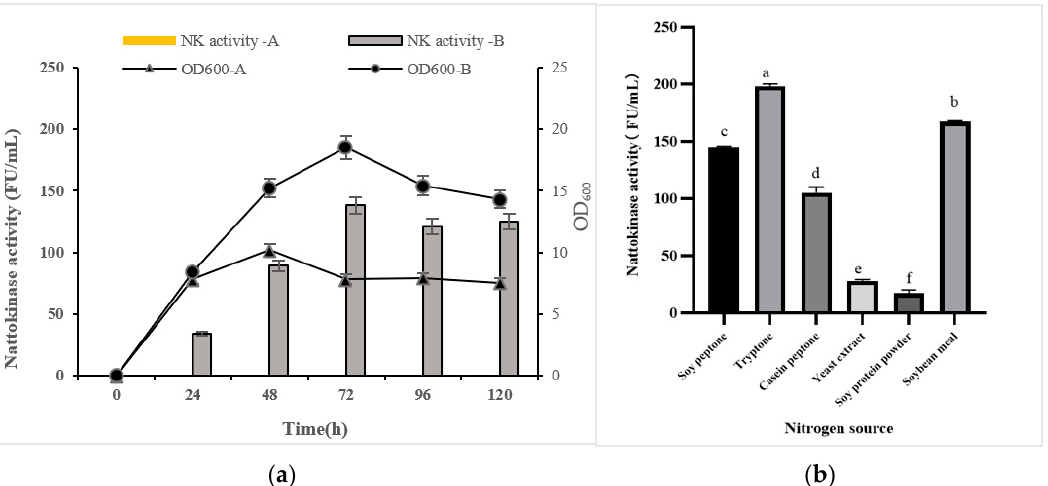
Figure 1 . Best conditions of the fermentation for PSP2 . ( a ) Growth and enzyme production in culture medium using oyster peptide as the sole nitrogen source (A) or in LB medium (B). ( b ) The enzyme production of oyster protein hydrolysate coexisting with additional nitrogen sources ( p < 0.05). Different lowercase letters in the figure indicate significant differences between values.